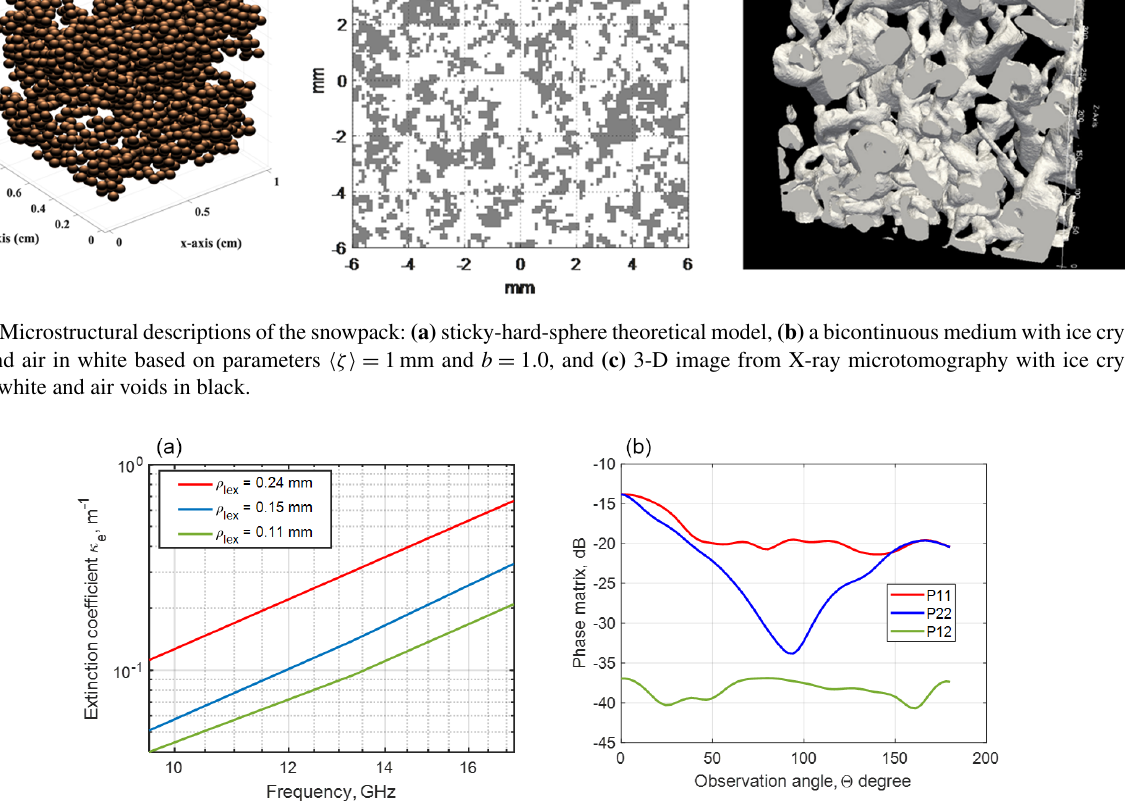
Figure 3. (a) Frequency dependence of the extinction coefficient from X- to Ku-band and (b) phase matrices at 13.3GHz for different values of microstructure correlation length ρ lex . Snow parameters are volume fraction f v = 0 . 20, aggregation parameter b = 1 . 2, and correlation length 0.15mm. P11 and P22 are co-polarized phase matrix elements, and P12 is a cross-polarized phase matrix